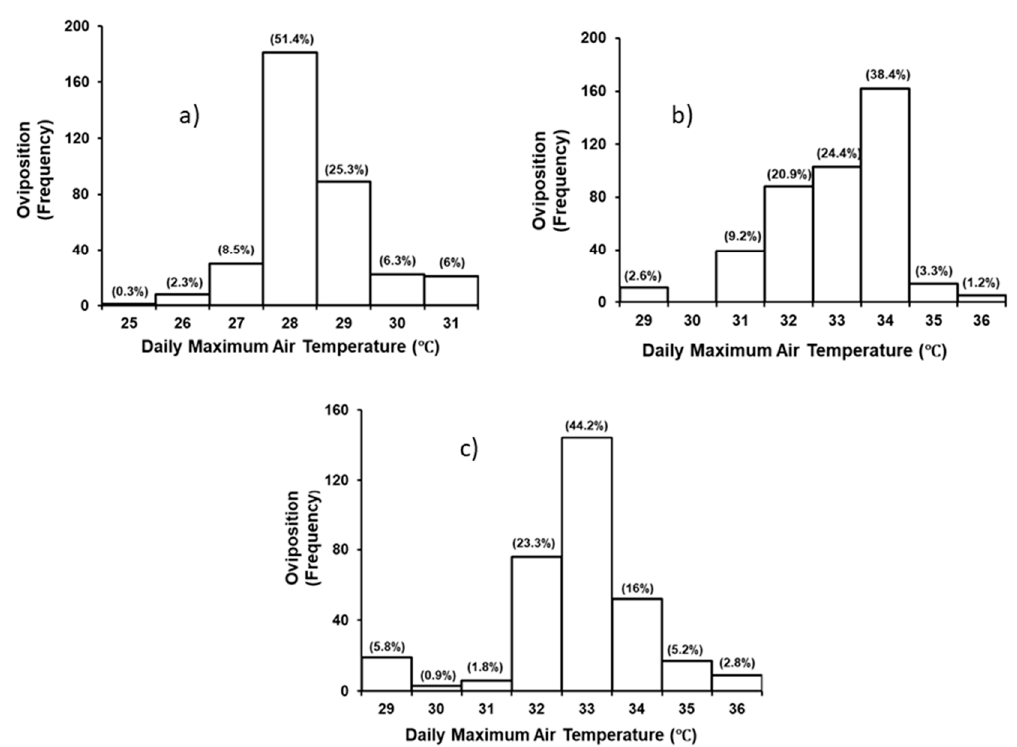
Figure 4. Number of Podocnemis unifilis turtles nesting in relation to the maximum daily air temperature in the Tawadu-Nichare Rivers, Venezuela. Three nesting seasons are ( a ) 1999, ( b ) 2000, and ( c ) 2001. Numbers in brackets indicate the total percent of nests laid at each temperature interval.